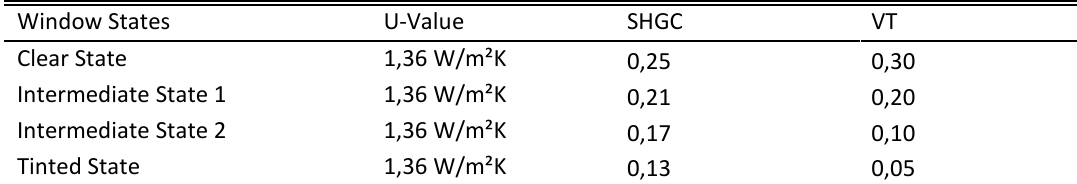
Table 6 Optical properties of thermochromic windows per state.